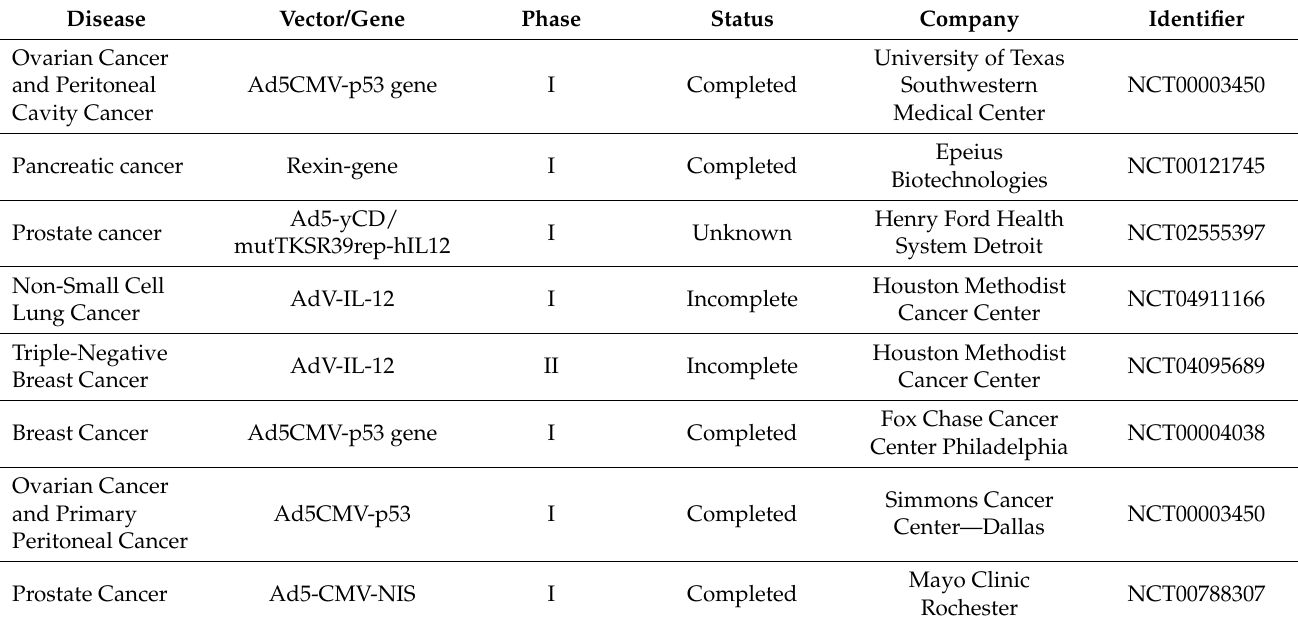
Table 1. Clinical trials for cancer gene